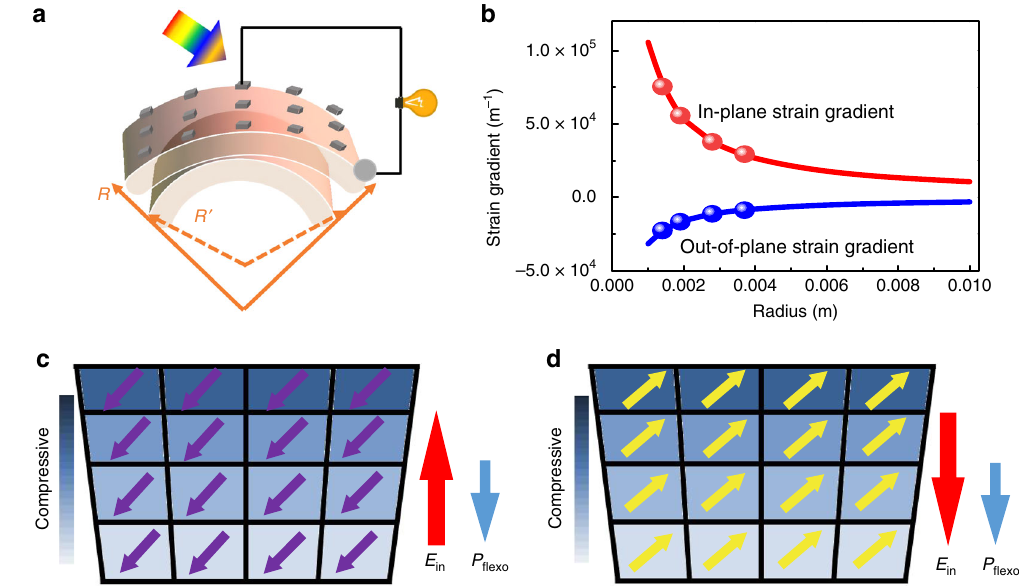
Fig. 1 Bending induced strain gradient in the fl exible device. a Schematic of the realization of the strain gradient by bending the freestanding BFO thin fi lm. b The solid lines are the calculated strain gradient as a function of the curvature radius. The eight solid points are the in-plane and out-of-plane strain gradients calculated from the four bending levels conducted in this work. Schematic of the stain status in the freestanding BFO thin fi lm with c downward polarization and d upward polarization. The purple and yellow arrows represent the downward and upward BFO polarizations that are along the body diagonal direction, respectively. The red arrow represents the BFO polarization-dependent internal electric fi eld ( E in ) of Pt/BFO/LSMO device, and the blue arrow shows the fl exoelectric polarization ( P fl exo ) generated by the fl exoelectric effect during